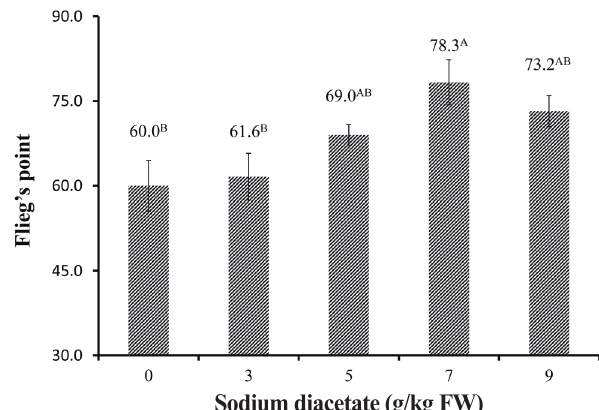
Figure 3. Aerobic stability of alfalfa silages treated with 0, 3, 5, 7, and 9 g/kg FW sodium diacetate ensiled for 60 days. Bars with unlike letters differ (p<0.05, n = 5). FW, fresh